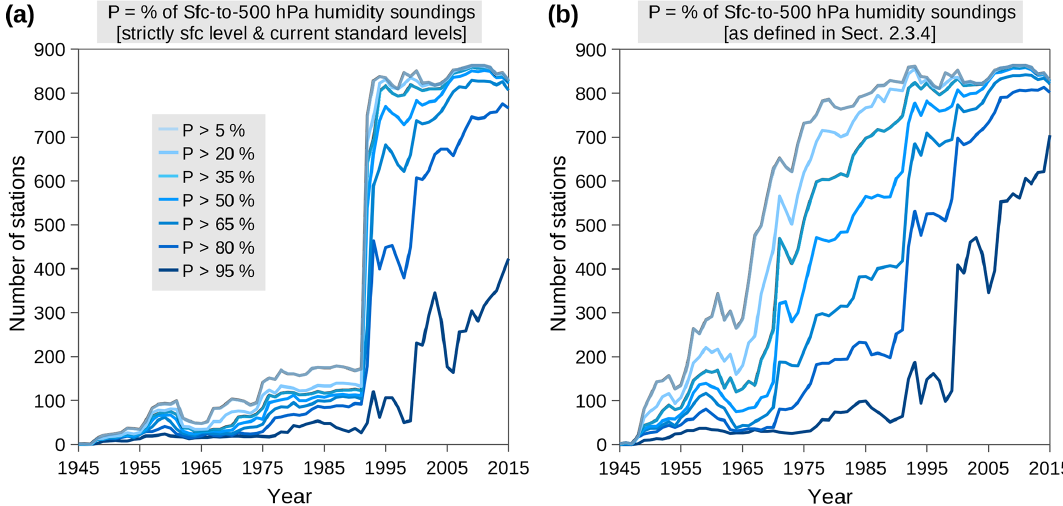
Figure 9. Number of stations for which the percentage of Sfc-to-500hPa humidity soundings, out of all soundings with humidity in each year, exceeds a given value (see inset of panel a ): (a) requiring humidity data at the surface level and all current standard levels above the surface up to 500hPa; (b) using the definition of “Sfc-to-500hPa humidity soundings” given in Sect. 2.3.4.